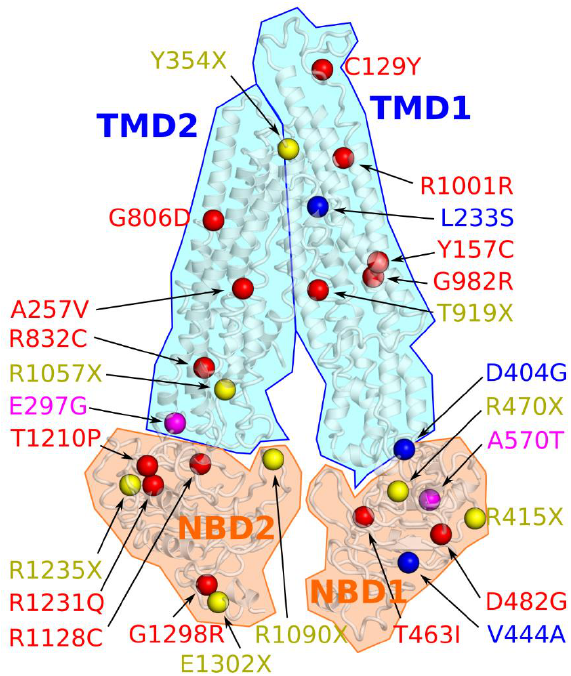
Figure 3. The positions of disease-causing mutations contained in Table 1 are shown in the ABCB11 cryo-EM structure. C-alpha atoms are shown as spheres and colored according to the resulting disease phenotype (PFIC2: red; BRIC2: blue; either PFIC2 or BRIC2: magenta; nonsense mutations: yellow). Outlines and filled colors indicate the domain organization of the transporter in accordance with Figure 1.